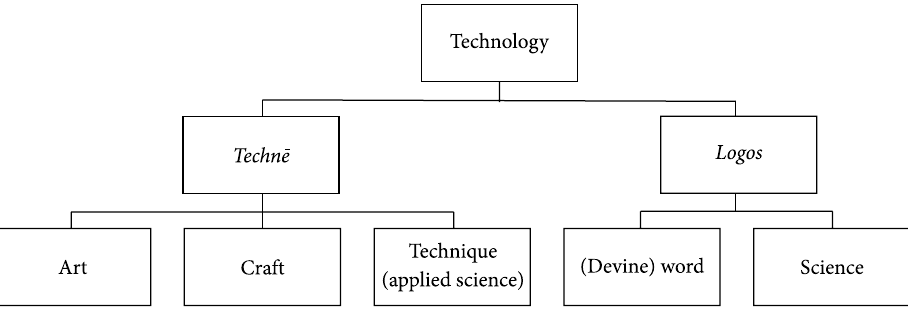
Fig. 3. Etymology of